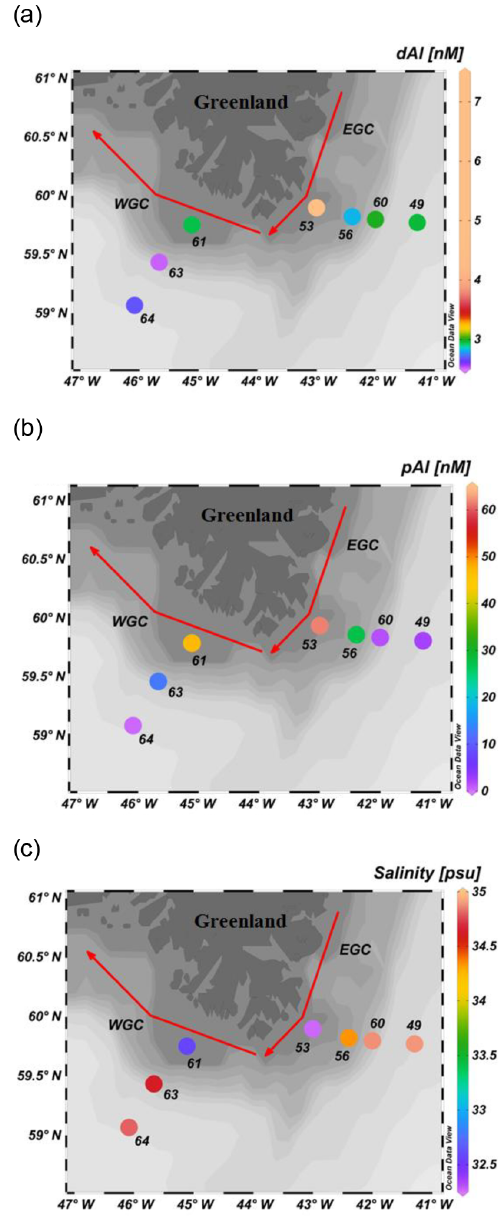
Figure 4. Surface concentration around the southern tip of Green- land of: (a) dAl (nM); (b) pAl (nM; Gourain et al., 2018); and (c) Salinity (psu). Red arrows represent the main surface currents. EGC and WGC stand for the East Greenland Current and West Greenland Current, respectively. Plots created in Ocean Data View (Schlitzer, 2018).